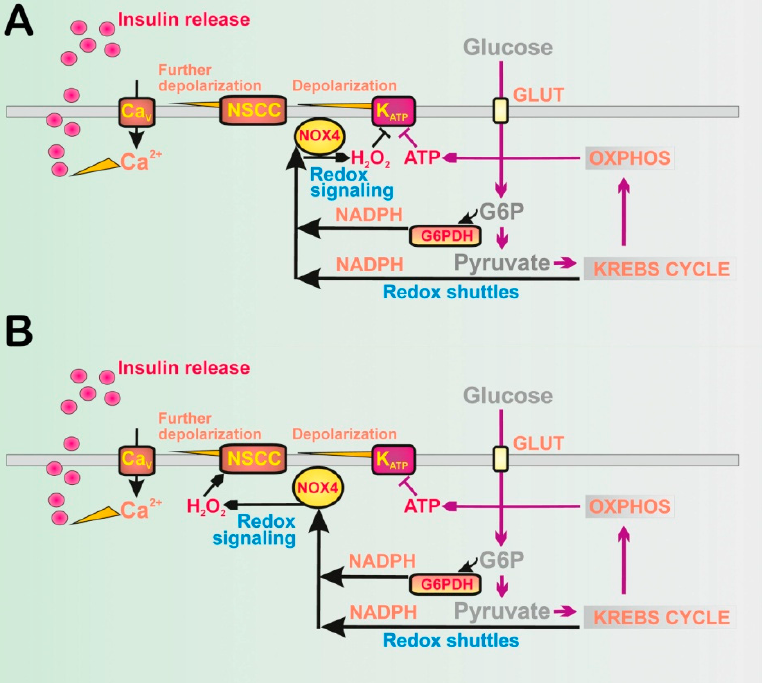
Figure 1. A new paradigm in the mechanism of glucose-stimulated insulin secretion (GSIS): Essential requirement of redox signaling. Upon glucose intake, pentose phosphate pathway (PPP) and redox shuttles supply cytosolic NADPH to increase NOX4 activity and thus elevate H 2 O 2 , which substantiates redox signaling. The two possible hypotheses assume two distinct targets of H 2 O 2 : either that ( A ) K ATP is closed exclusively when both ATP plus H 2 O 2 are elevated (as supported by the patch-clamp data in Ref. [4]); or ( B ) that K ATP is closed by ATP, whereas the TRPM2 channel (or other nonspecific calcium channels (NSCCs)) is activated by H 2 O 2 . In both cases, the depolarization shift by NSCCs is essentially required for achieving the − 50 mV depolarization threshold for Ca V activation despite 100% of the K ATP ensemble being closed. Mechanism ( A ) plus additional H 2 O 2 stimulation of TRPM2 is also plausible.